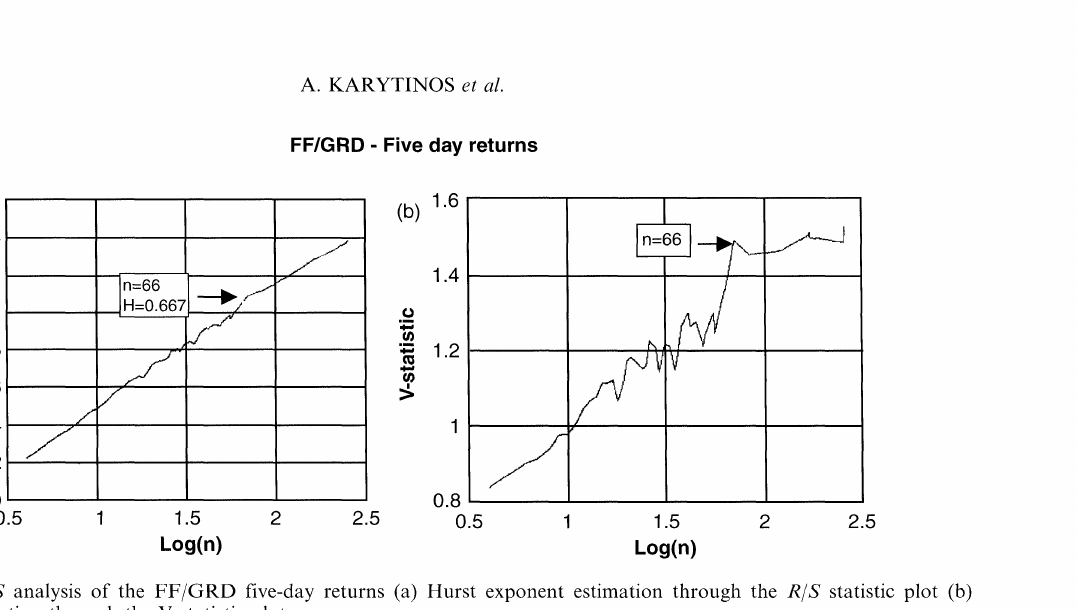
FIGURE ll R/S analysis of the FF/GRD five-day returns (a) Hurst exponent estimation through the R/S statistic plot (b) Cycle-length estimation through the V-statistic plot.